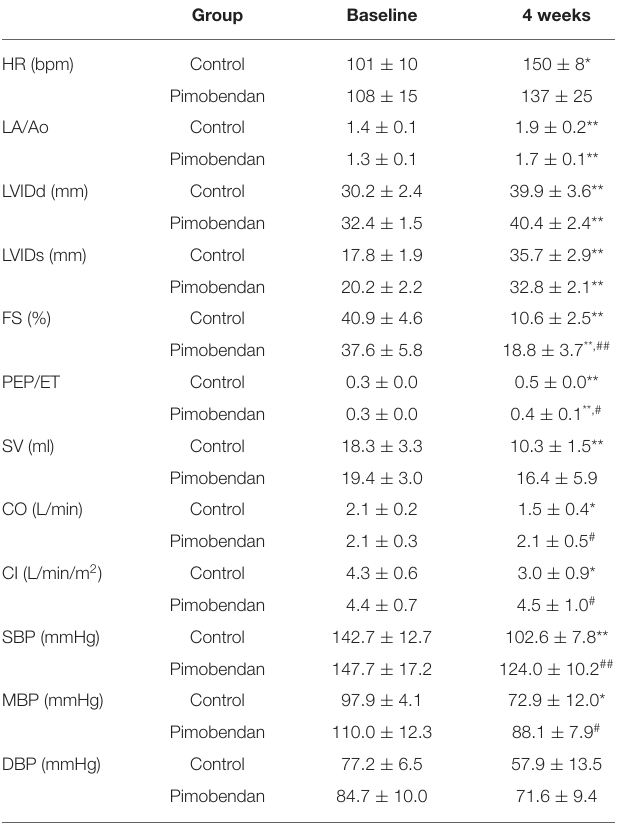
TABLE 1 | Values of echocardiography and blood pressure measurement.